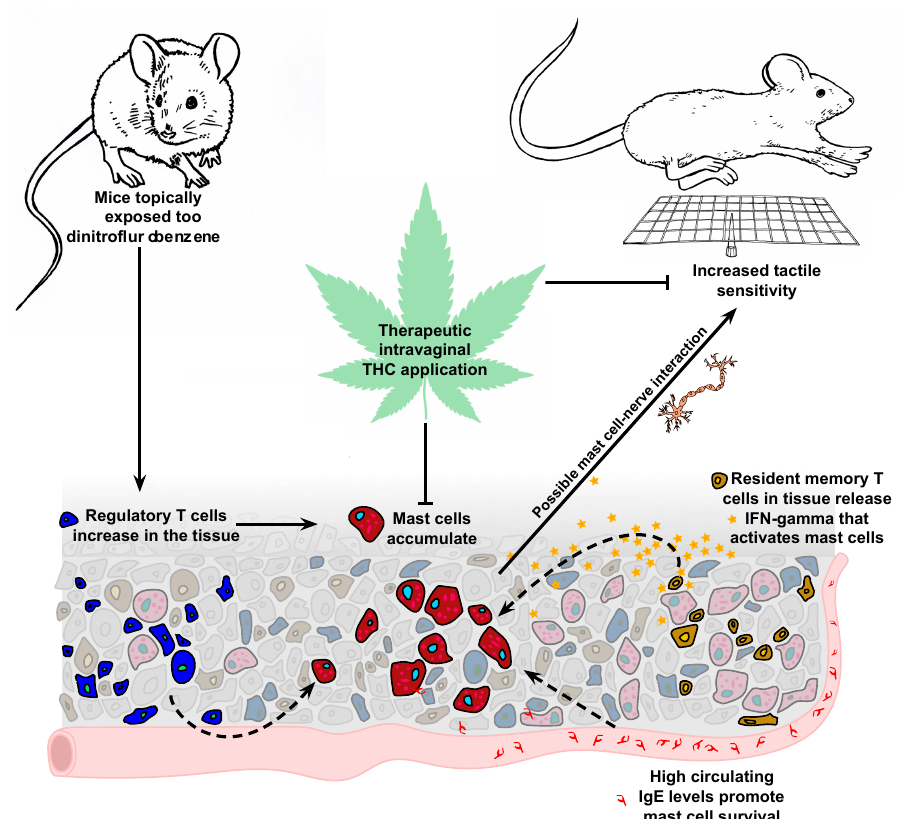
Figure 5. Repeated DNFB exposures on the skin lead to accumulation of regulatory T cells, resident memory T cells and mast cells. Mast cell increases are correlated with increased tactile sensitivity; therapeutic intra-vaginal THC application reduces mast cell density and tactile pain. Solid arrows indicate the hypothesized mechanisms proposed in this model. Dotted lines indicate previously published experimental observations of the contributions of regulatory T cells, IFN- γ and circulating IgE to mast cell recruitment, survival and activity in the tissue. T-bars indicate suppression of mast cell accumulation and tactile sensitivity following THC application. Artwork by Amy Pelz.